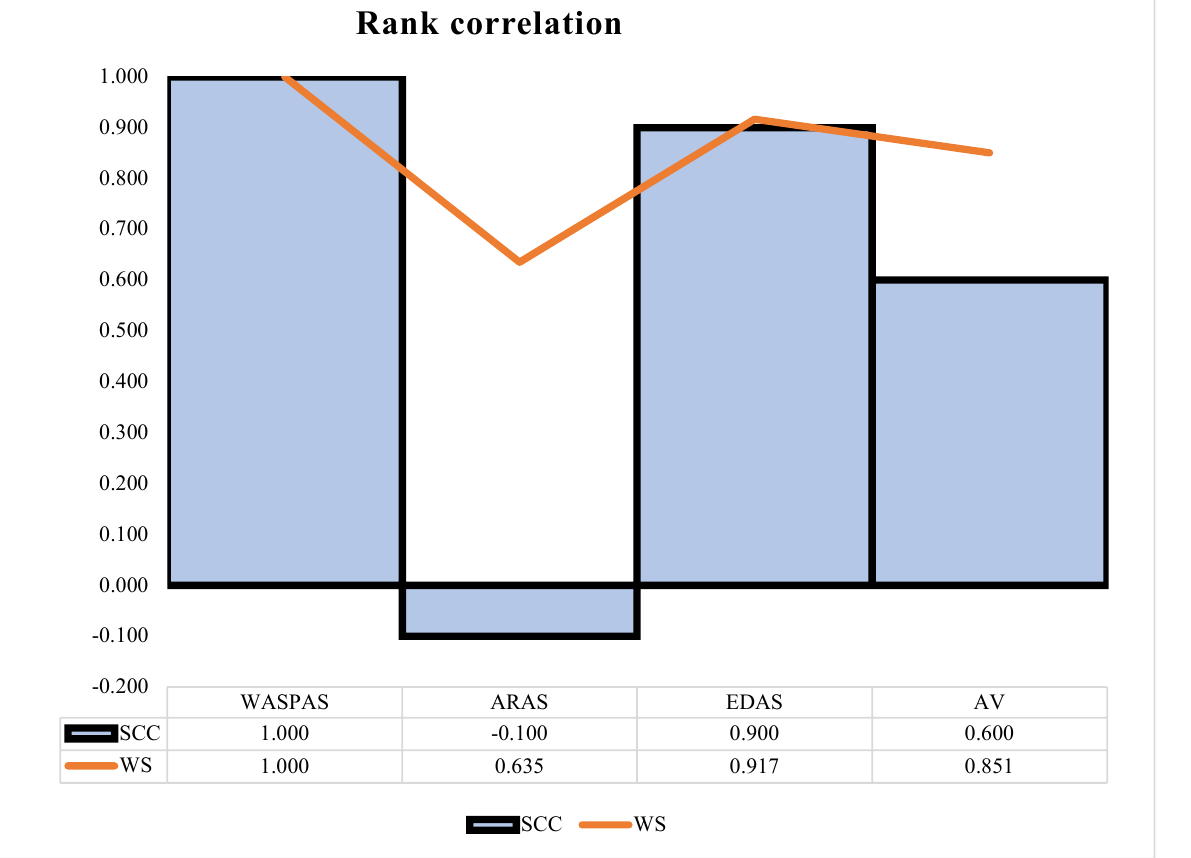
Figure 9. Correlation of ranks calculated with SCC and WS